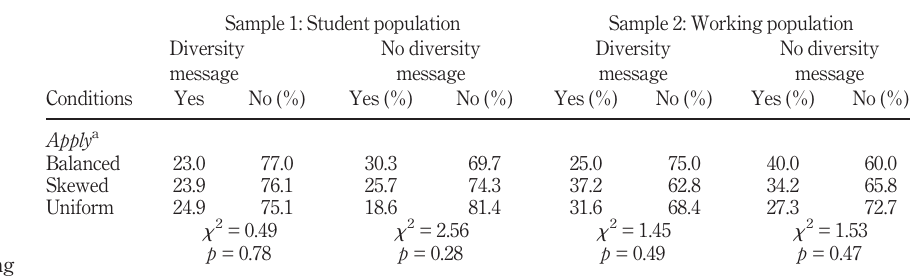
Table 3. Cross-tabulation results for applying behavior